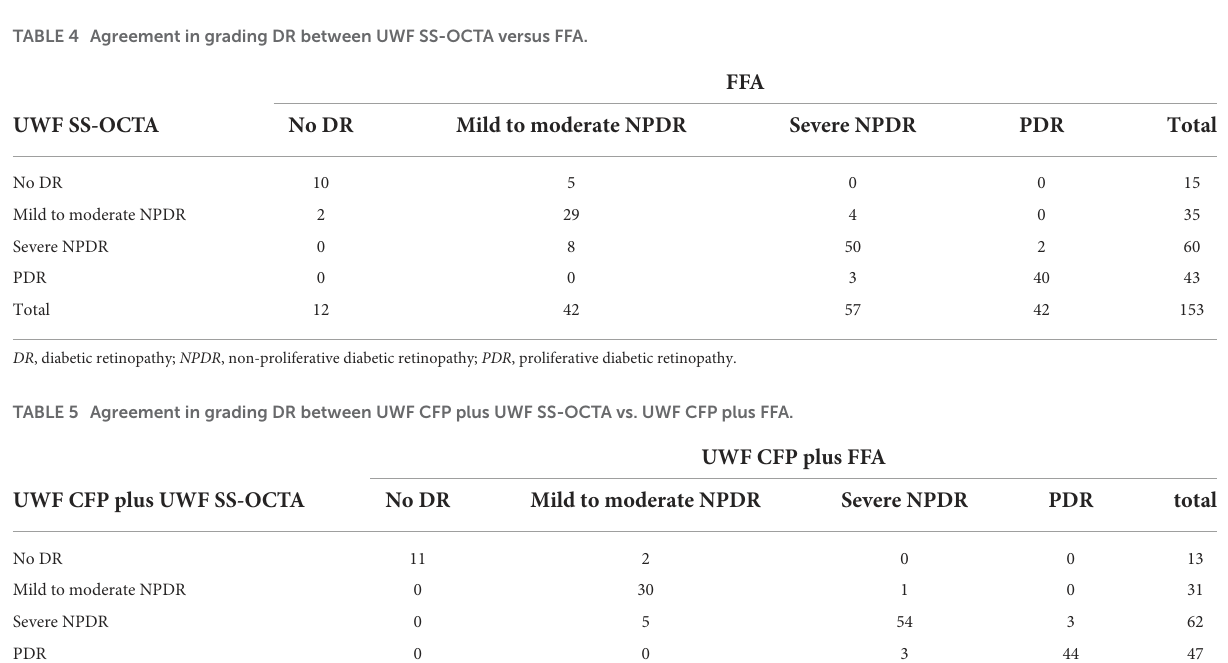
TABLE 4 Agreement in grading DR between UWF SS-OCTA versus FFA.